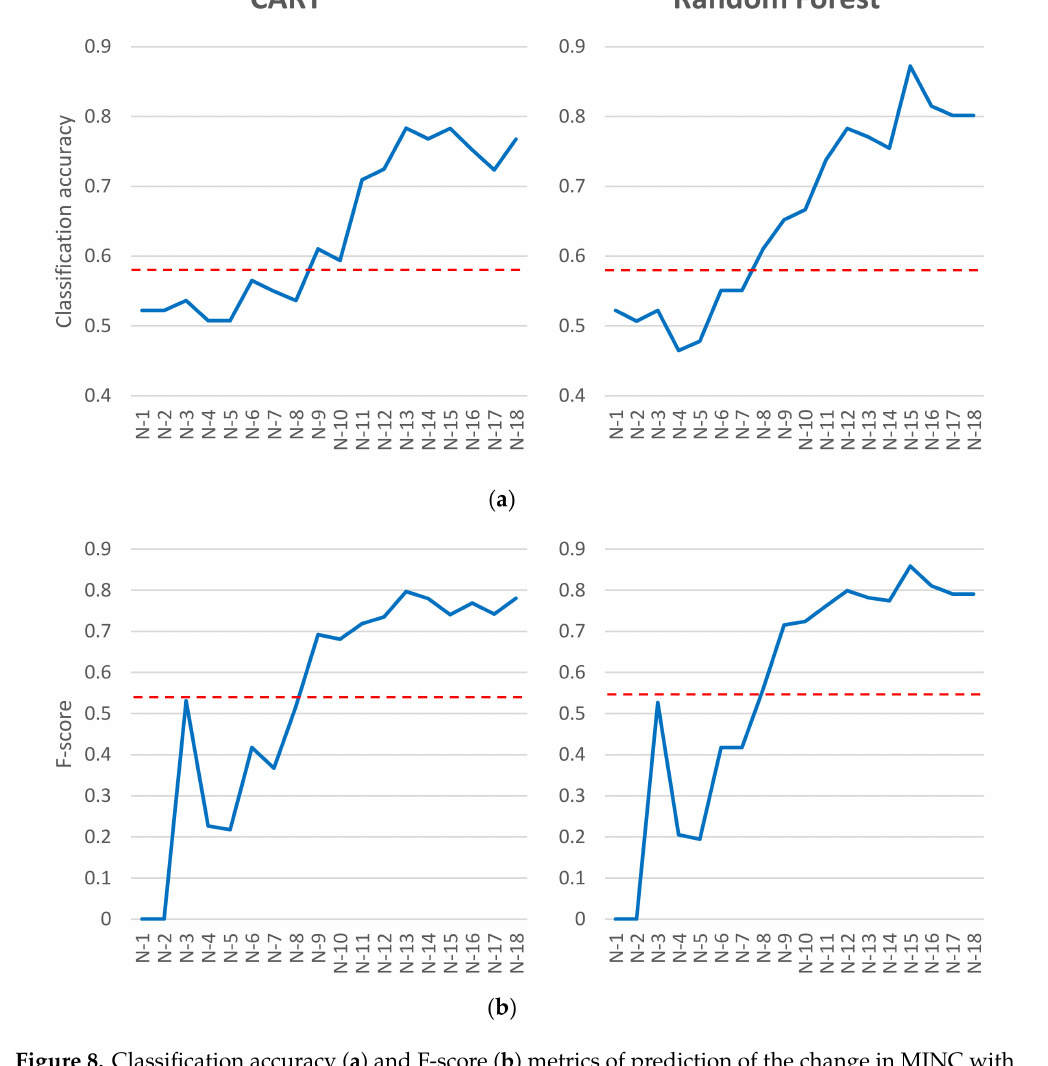
Figure 8. Classification accuracy ( a ) and F-score ( b ) metrics of prediction of the change in MINC with the addition of historical changes for both classifiers for project httpcore . Dotted lines present the performance of the best general